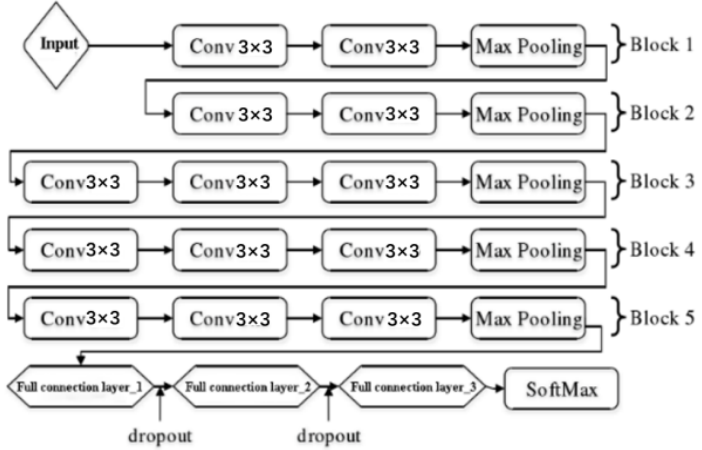
Figure 6. VGG16 structure diagram.